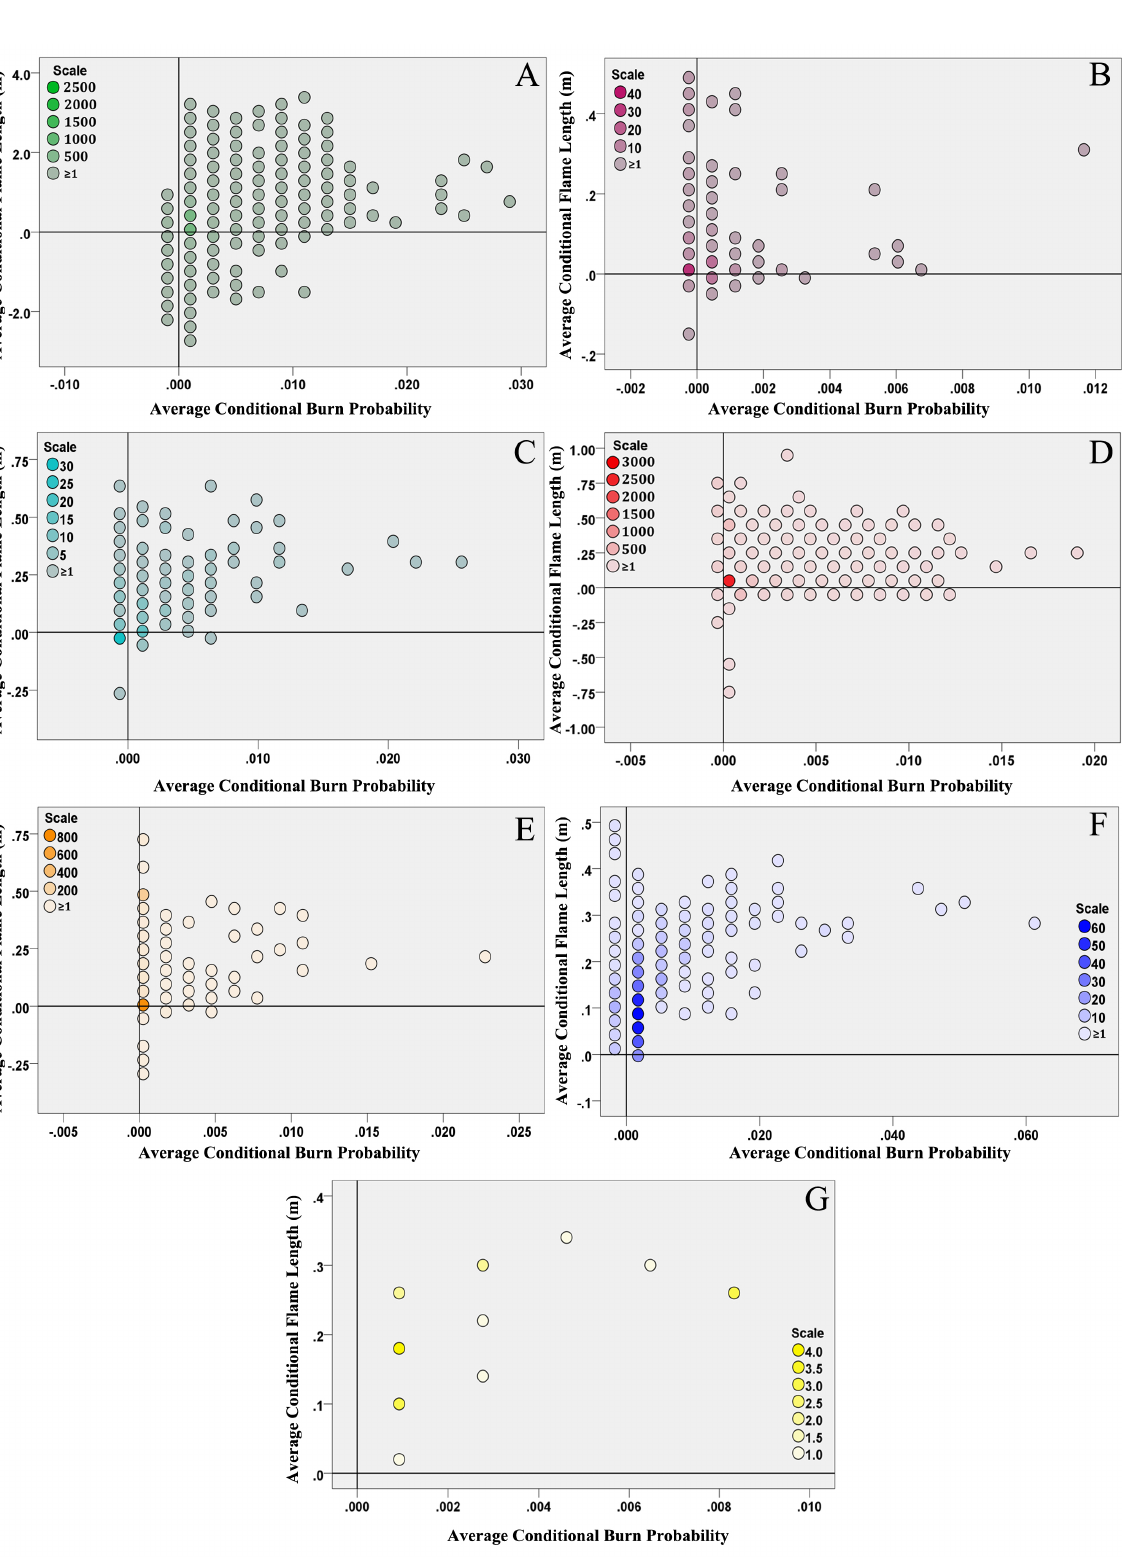
Figure 7. Hex-binned scatterplots of the two time periods CBP and CFL differences (Future minus Present) for: ( A ) agricultural installations; ( B ) hotels, ( C ) monuments, ( D ) houses, ( E ) industries/businesses, ( F ) WUI sites and ( G ) wildlife habitats (scale refers to the number of cases contained at each colored hex